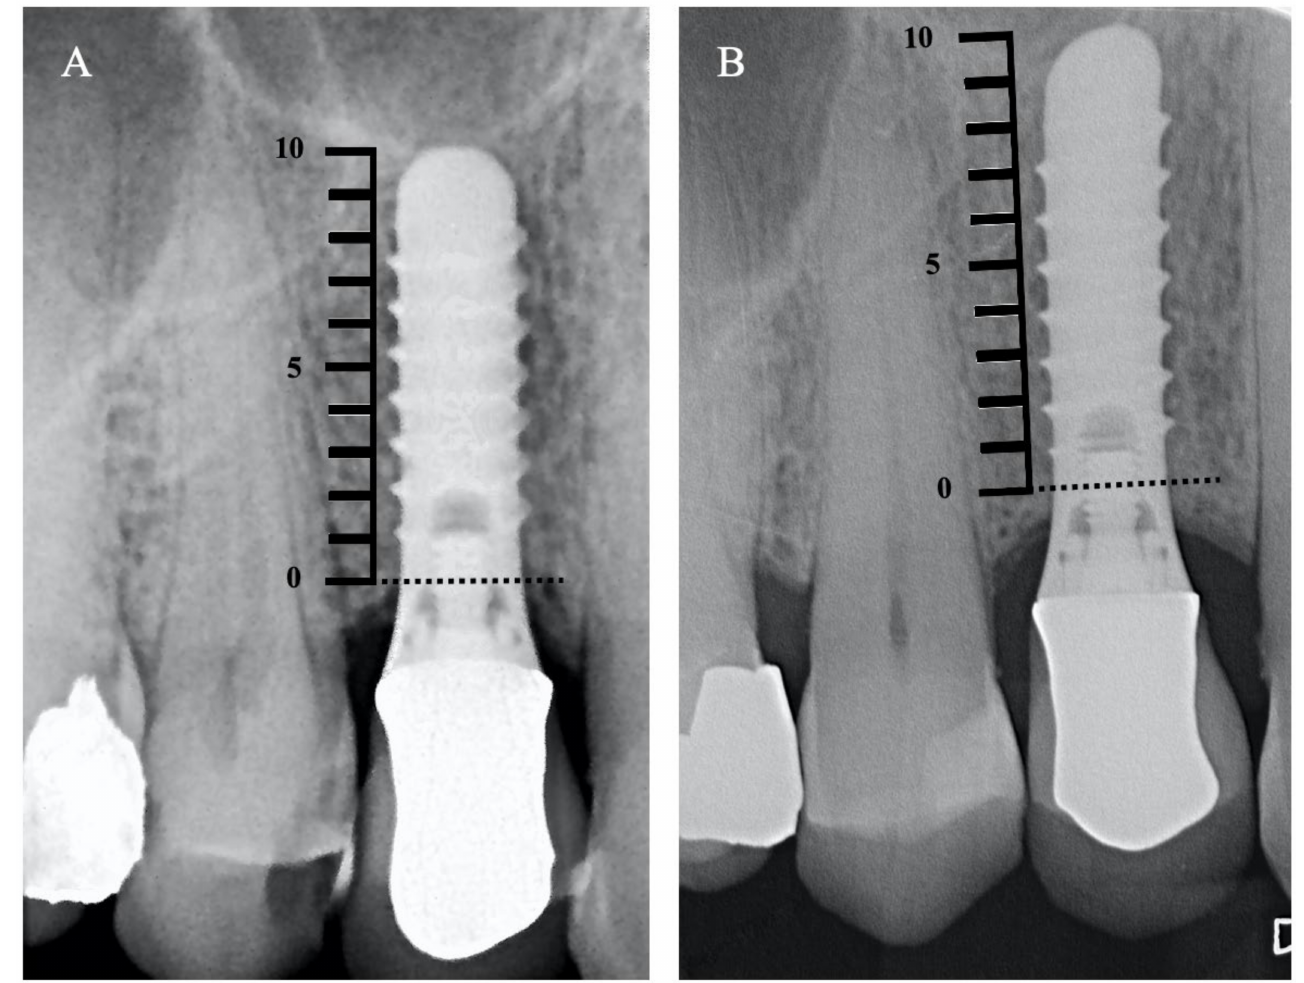
Figure 1. Representative X-rays of an implant of the platform matching group, ( A ). Prosthetic baseline, ( B ). Follow-up.